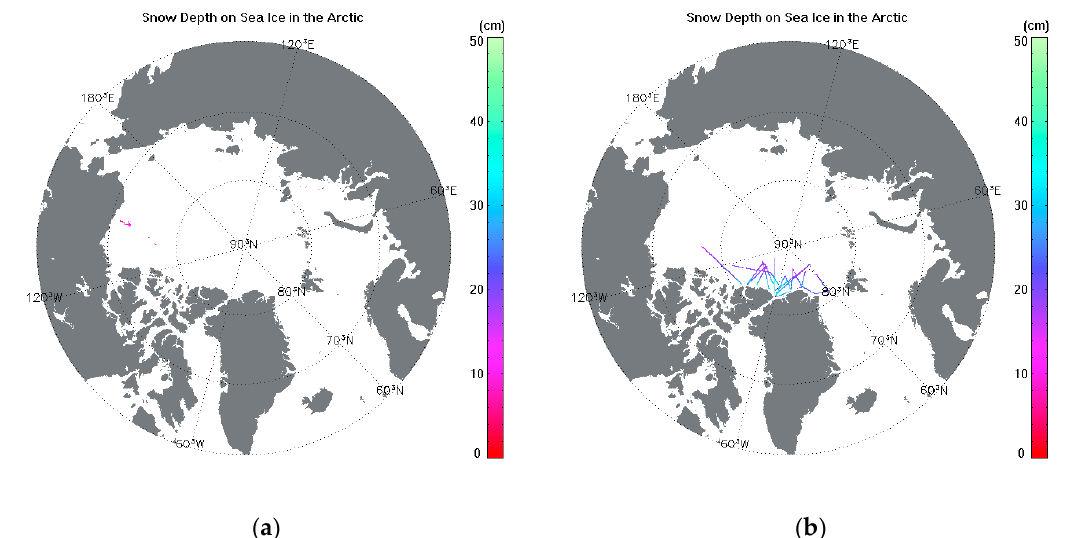
Figure 18. Spatial distribution of snow depths for verification. ( a ) FYI; ( b ) MYI. After data preprocessing, we obtained 42 matchup data for FYI and 784 for MYI. The average snow depth on the FYI is 12.19 cm, and the Std is 4.41 cm; the average snow depth on MYI is 23.68 cm, with a Std of 5.74 cm. The verification results are presented in Table 9.